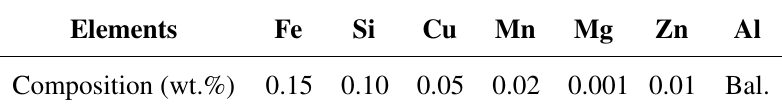
Table 1. Chemical composition of the AA1100 base alloy.